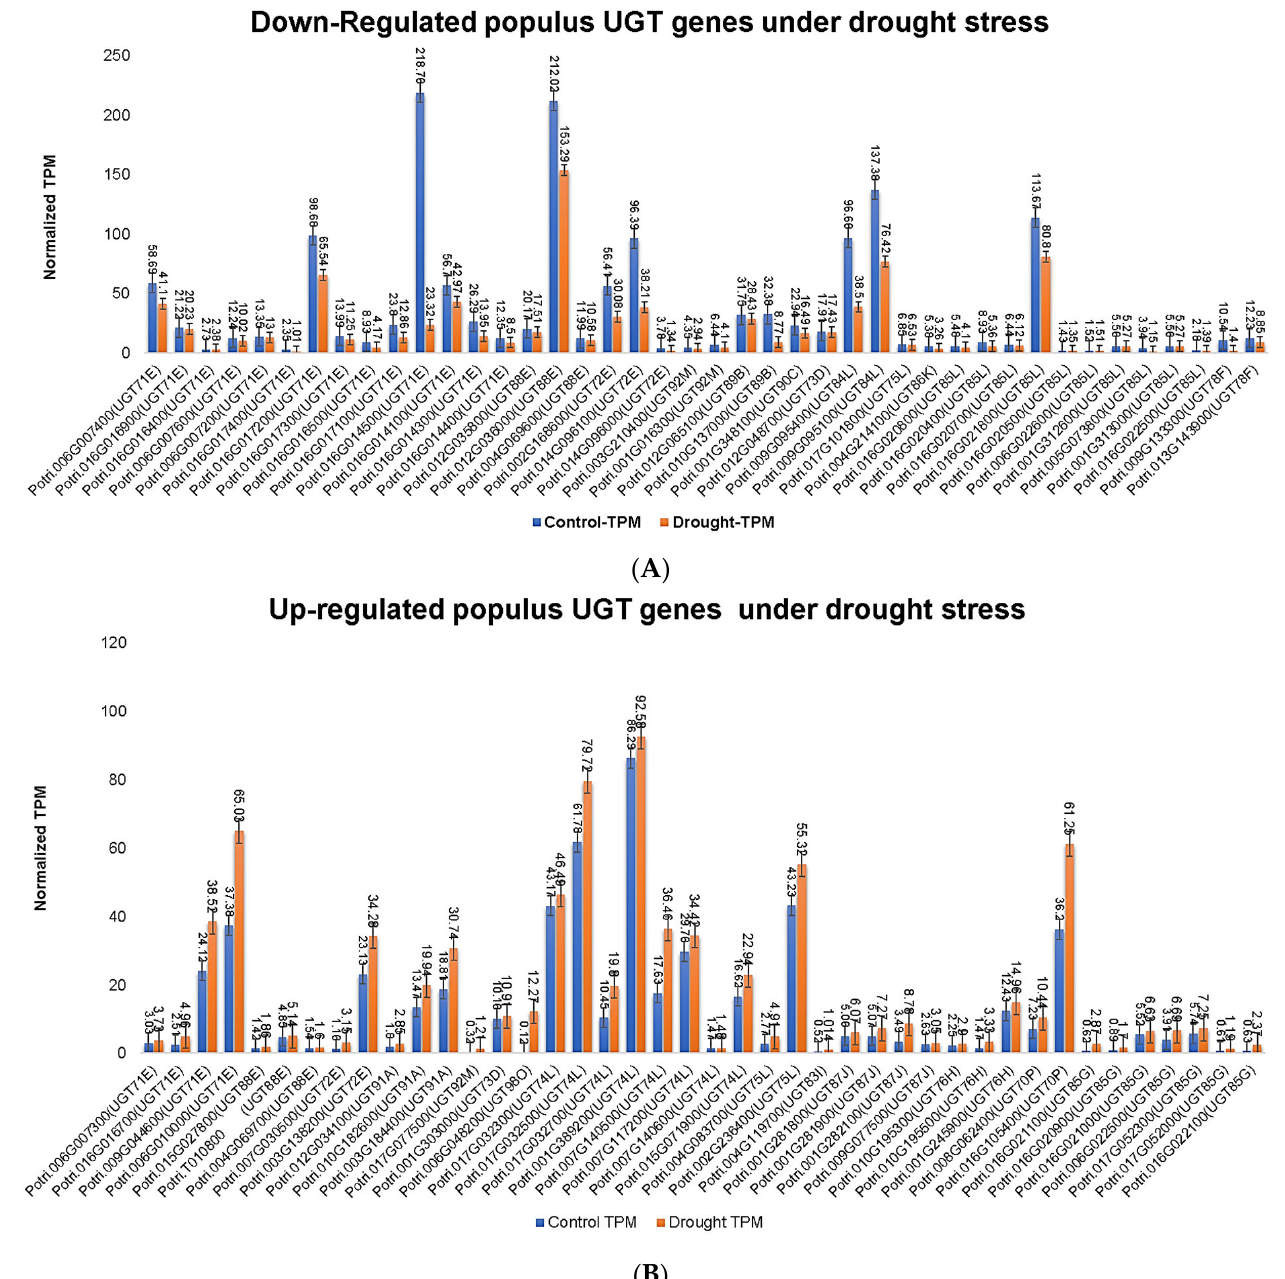
Figure 7. Regulation of UDP glycosyltransferases (UGTs) under drought conditions with their gene expression values in TPM (A,B) . ( A ) Down-regulation of UGTs under drought and control conditions. ( B ) Up-regulation of UGTs under drought and control conditions.